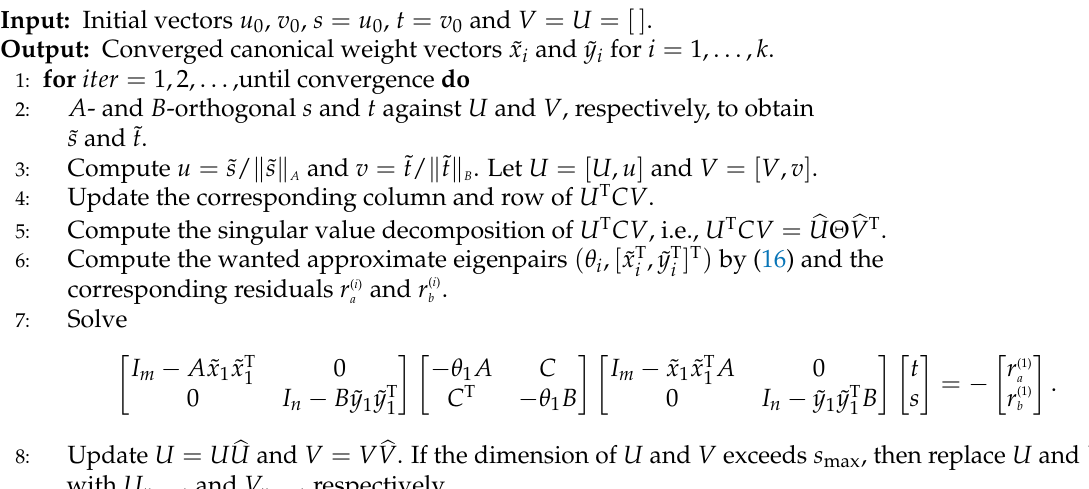
Algorithm 1 Jacobi–Davidson method for canonical correlation analysis